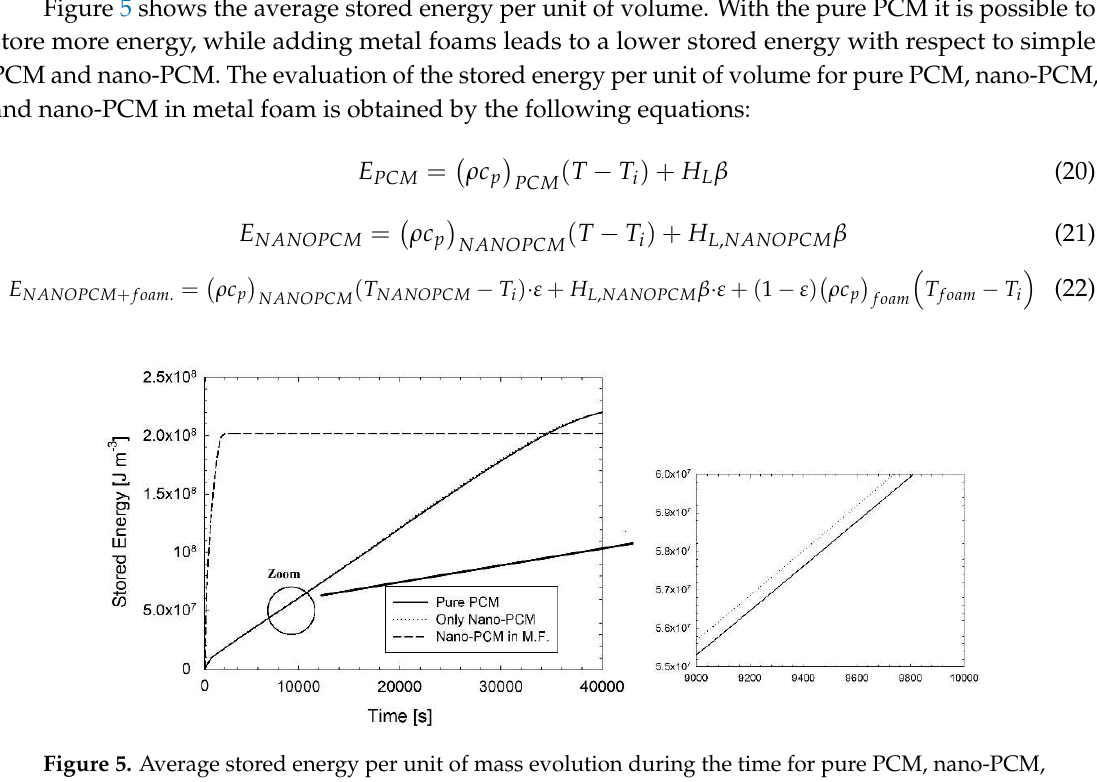
Figure 4. Average temperature evolution during the time for pure PCM, nano-PCM, nano-PCM in metal foam (M.F.), and metal foam.